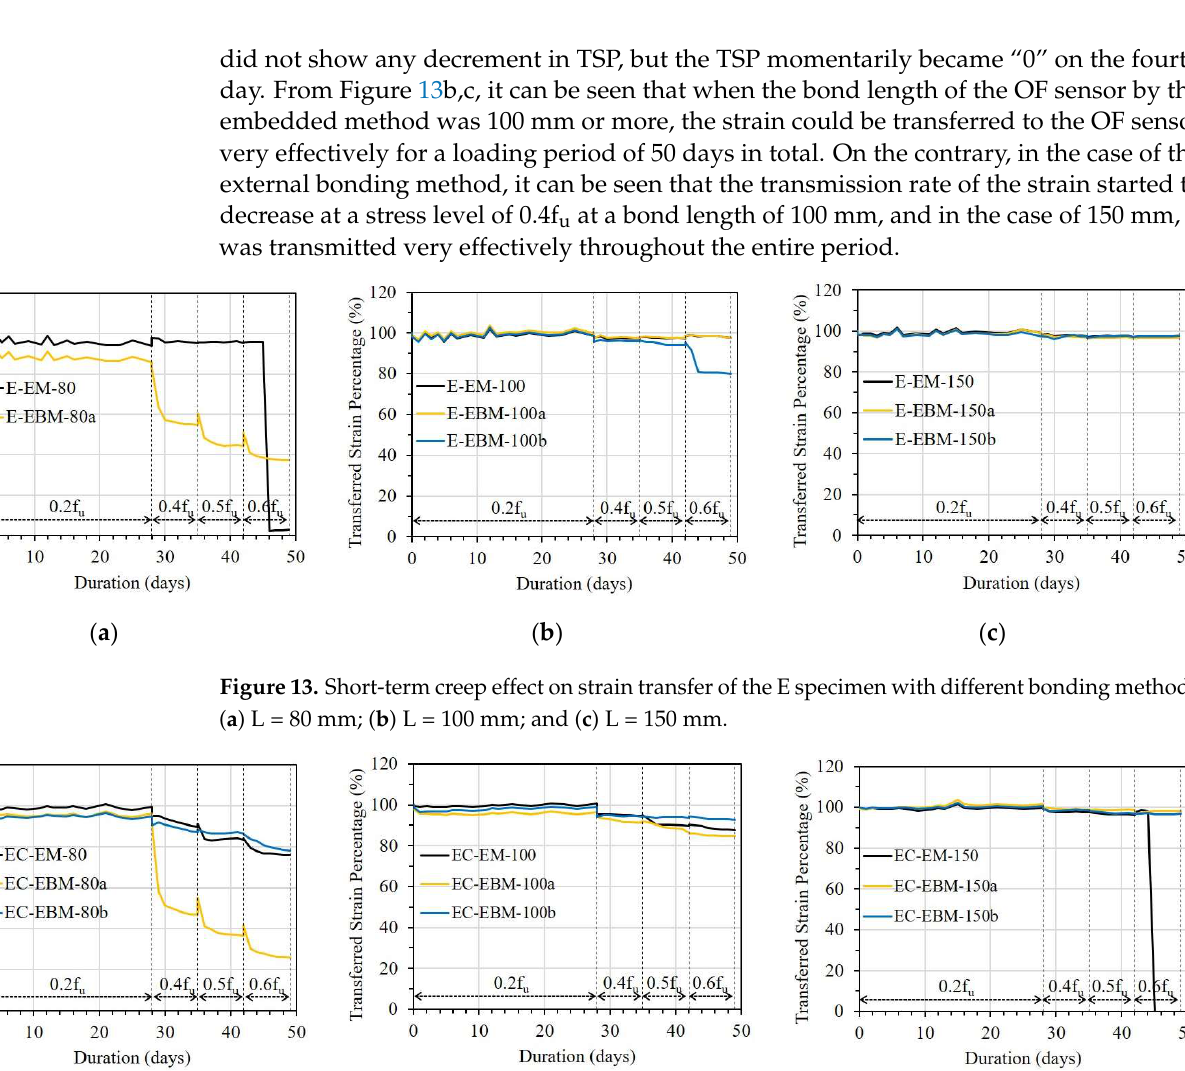
Figure 13. Short-term creep effect on strain transfer of the E specimen with different bonding meth- ods: ( a ) L = 80 mm; ( b ) L = 100 mm; and ( c ) L = 150 mm.